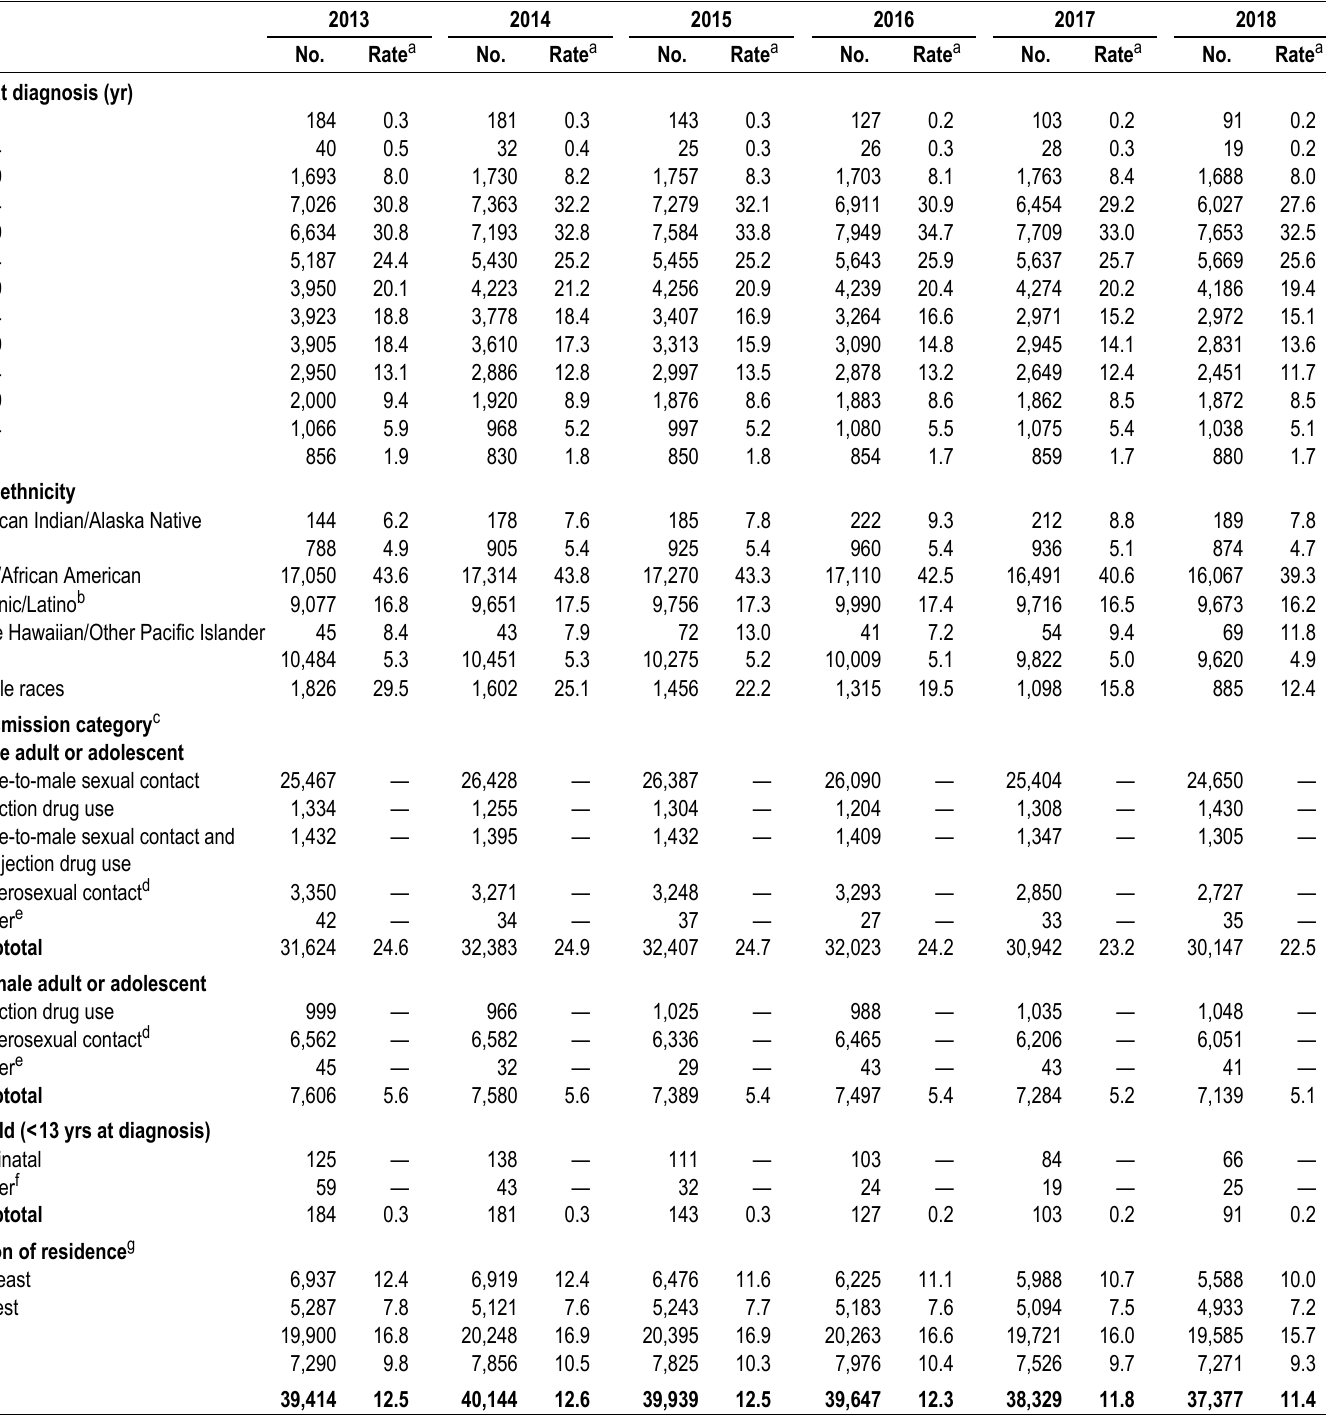
Table 1a. Diagnoses of HIV infection, by year of diagnosis and selected characteristics, 2013–2018—United